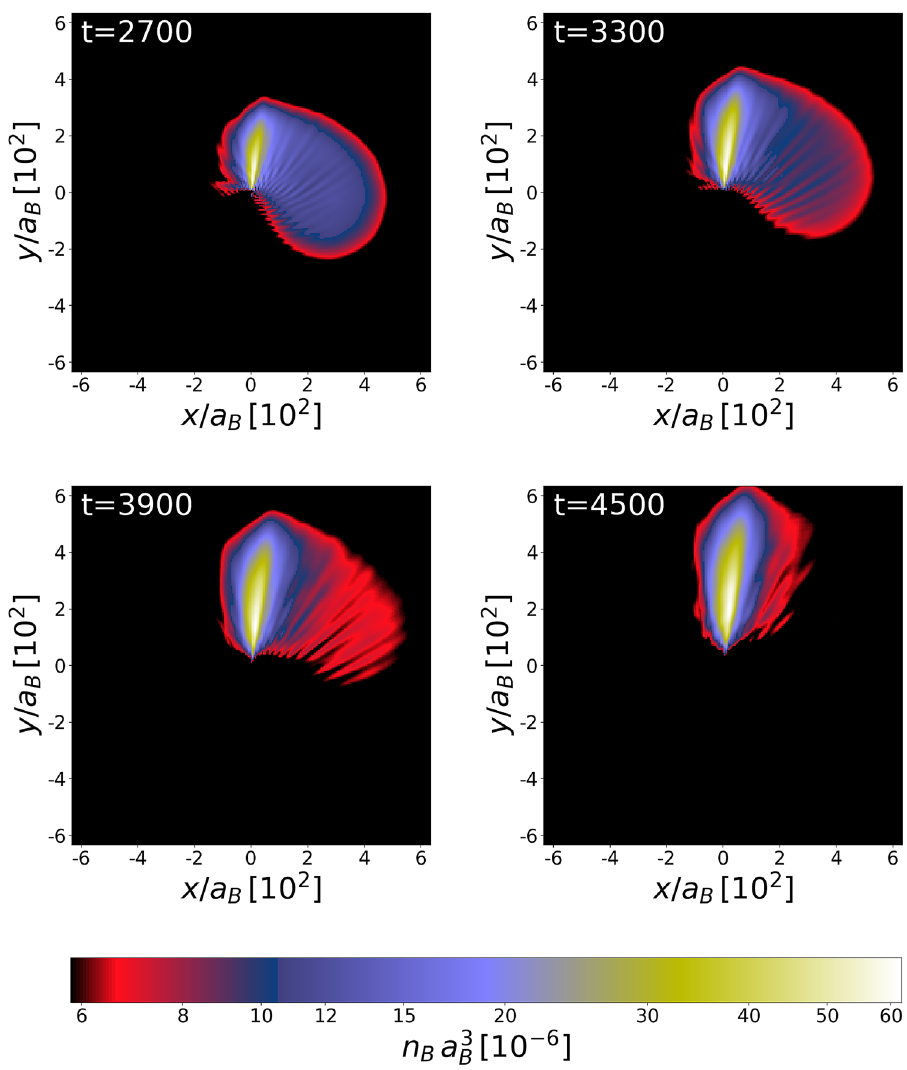
and its disruption looks differently than in Fig. 6. The bulk of the white dwarf flows around the black hole rather than it drops on it in pieces, resembling a bit results obtained within the SPH simulations 58 . The unit of time is ( m B a 2 B )/ (cid:31)